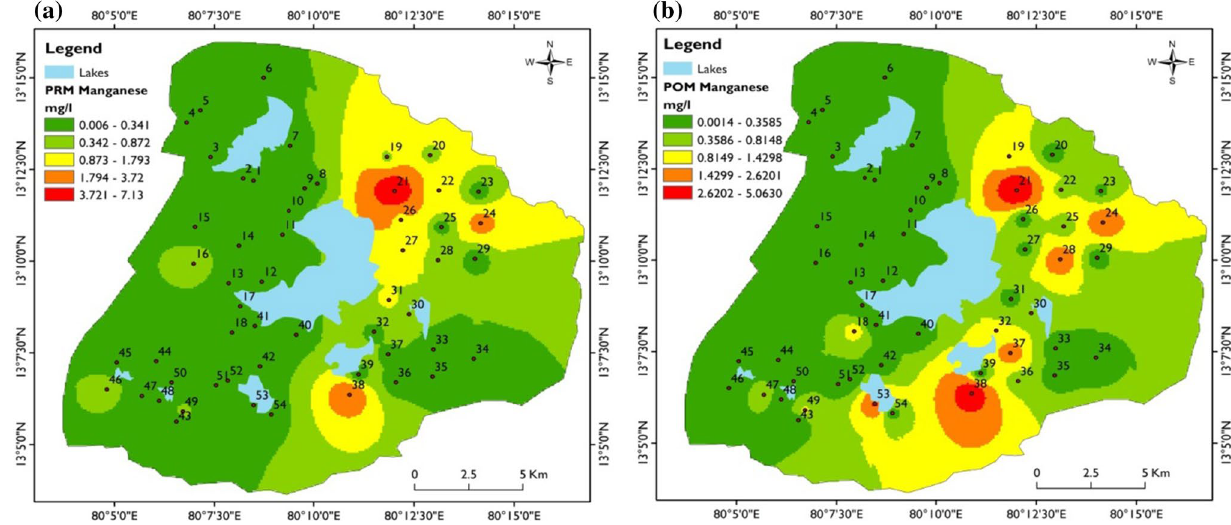
Fig. 4 a , b Spatial variation of Mn in the groundwater for pre-monsoon and post-monsoon, respectively